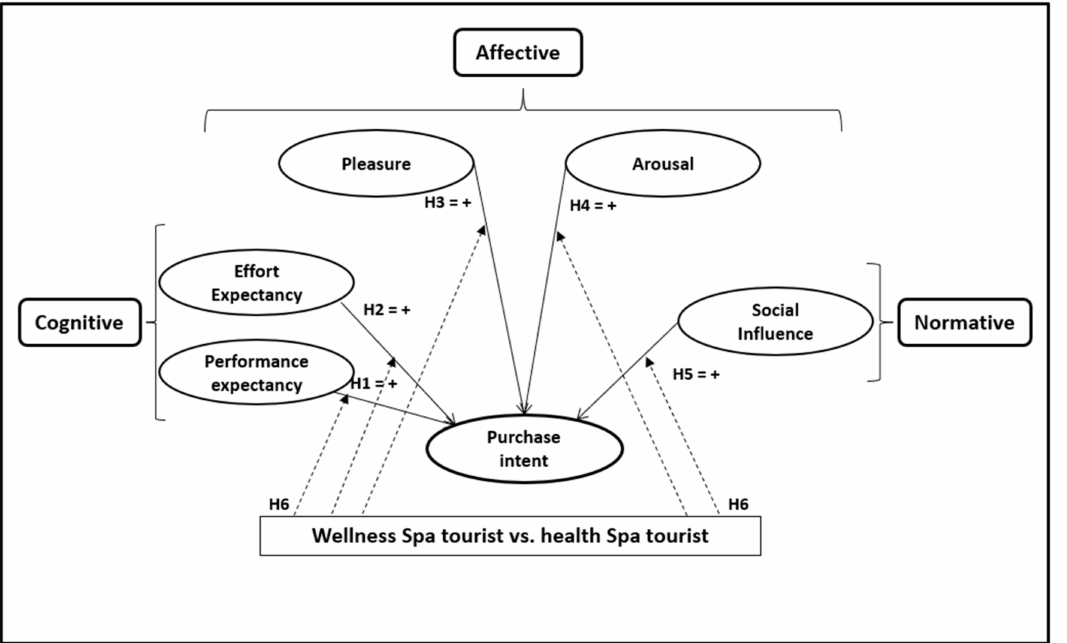
Figure 1. Proposed hypothesis